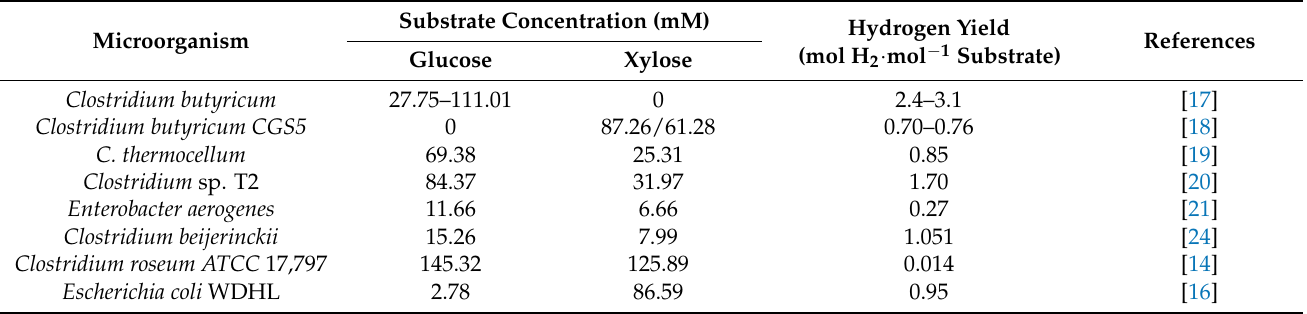
Table 1. The hydrogen yield from different sugar concentrations and glucose/xylose